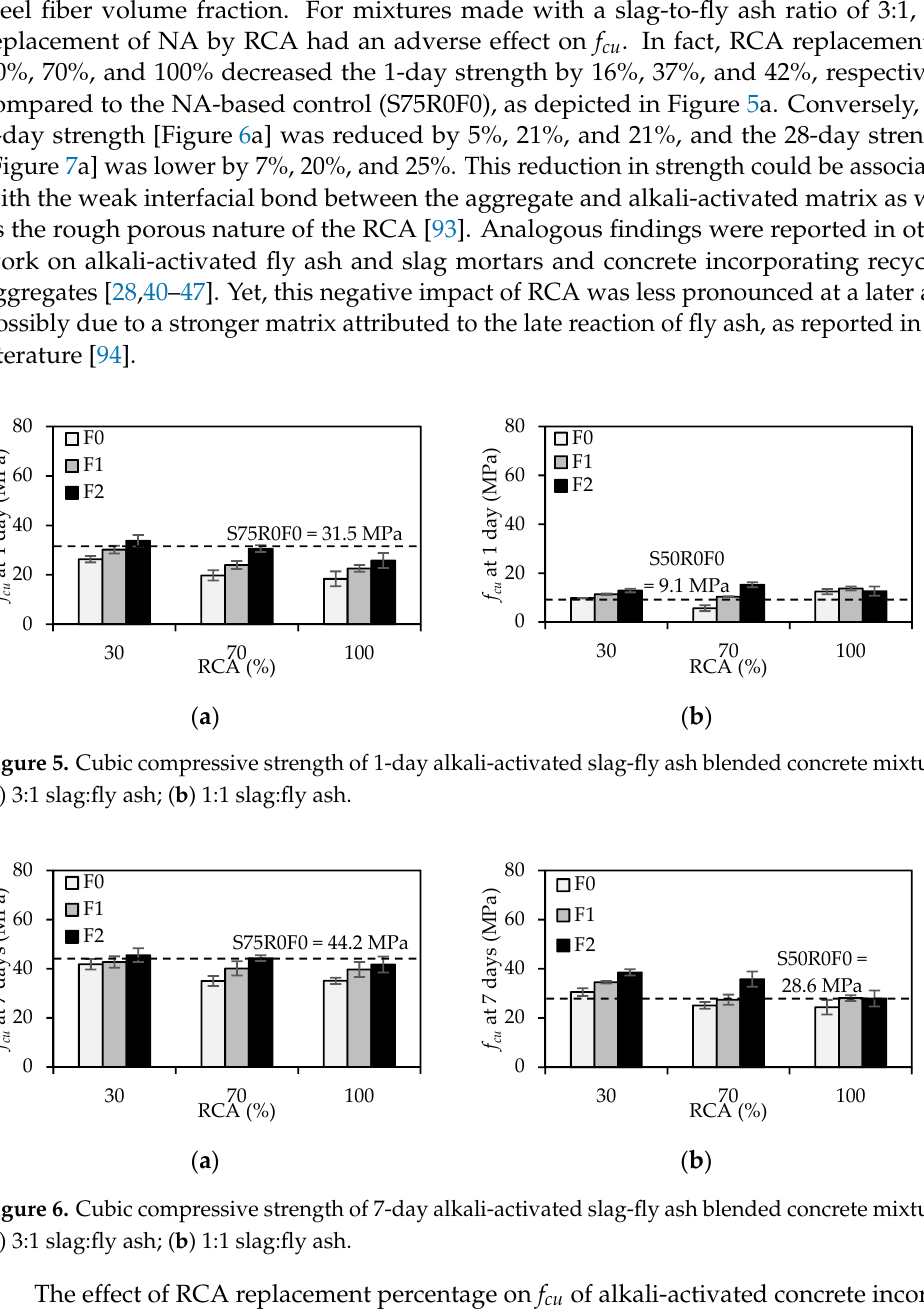
Figure 7. Cubic compressive strength of 28-day alkali-activated slag-fly ash blended concrete mix- tures: ( a ) 3:1 slag:fly ash; ( b ) 1:1 slag:fly ash. The effect of RCA replacement percentage on f cu of alkali-activated concrete incorpo- rating equal proportions of slag and fly ash is shown in Figures 5b, 6b, and 7b. Generally, the replacement of NA by RCA did not have a significant impact on the 1-day strength, owing to a possibly sufficient interfacial bond between the alkali-activated binder and coarse aggregates (NA and RCA). Figure 6b presents the 7-day cube compressive strength. While the replacement of NA by 30% RCA did not have a substantial effect on the 7-day strength, higher replacements of 70% and 100% reduced the strength by 12% and 15%, respectively. Furthermore, the 28-day f cu values ranged between 28.1 and 43.4 MPa, as shown in Figure 7b. While the control mixture with 100% NA had a 28-day f cu of 35.3 MPa, those of mixtures that replaced NA by 30%, 70%, and 100% RCA were 31.0, 28.2, and 28.1 MPa, representing decreases of 12%, 20%, and 20%, respectively. Similar findings were reported in alkali-activated concrete made with a single precursor, i.e., class C fly ash, class F fly ash, or slag [42,44,95]. 4.1.3. Effect of Steel Fiber Addition The influence of adding steel fibers on f cu of alkali-activated slag concrete made with 25% fly ash is examined in Figures 5a, 6a and 7a. Compared to the plain counterparts, the 1-, 7-, and 28-day strength increased, on average, by 20%, 10%, and 13% upon adding 1% steel fibers, by volume, respectively, and by 41%, 18%, and 22% with 2% steel fiber volume fraction, respectively. Clearly, steel fibers countered the negative effect of RCA replace- ment, especially at higher volume fractions due to the bridging effect of steel fibers, in- crease in density of the matrix, and reduction in the pore space, evidenced by the lower water absorption and sorptivity results shown later. Yet, the improvement in f cu seemed to be superior at the age of 1 day. Similar enhancements in compressive strength were noted in steel fiber-reinforced alkali-activated concrete made with NA [36,96]. Indeed, it is possible to produce alkali-activated slag-fly ash (3:1) concrete incorporating dune sand with up to 30% RCA replacement without steel fibers and up to 100% RCA with 2% steel